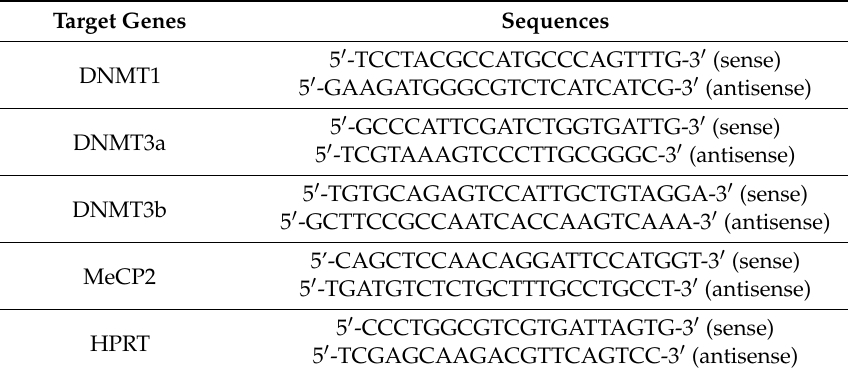
Table 2. Primer sequences used for RT-PCR